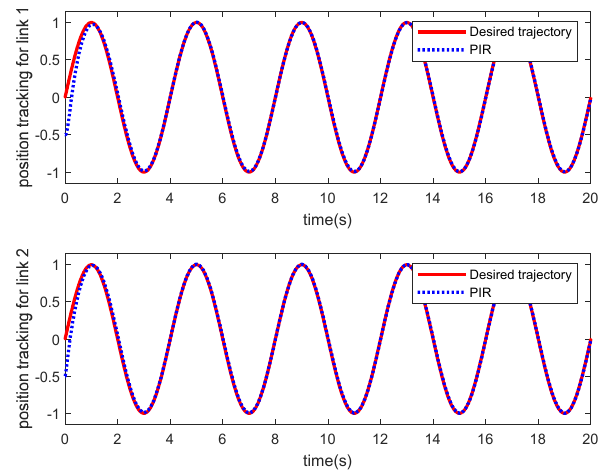
Figure 8. Trajectory tracking performance of PIR.